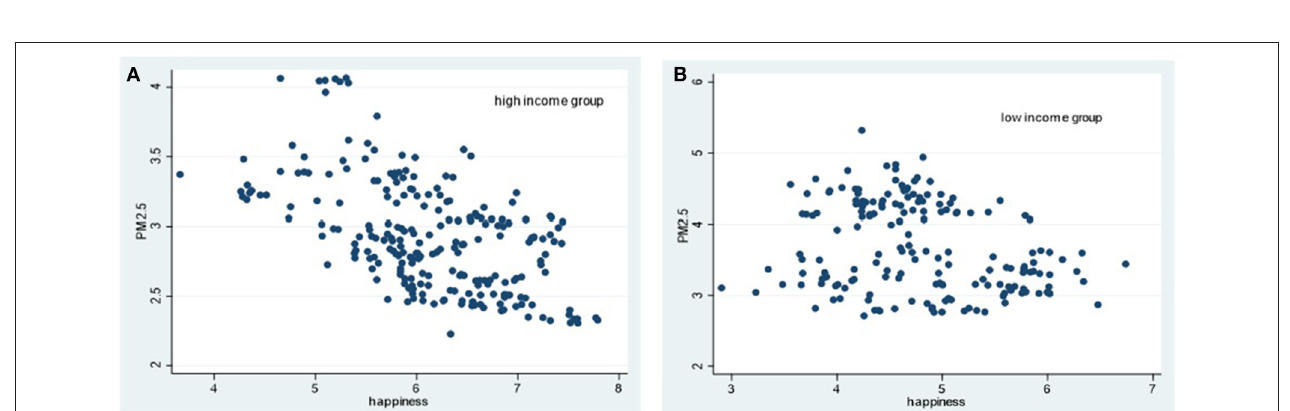
FIGURE 1 | Scatter diagram of relationship between PM2.5 concentration and happiness in different income groups. (A) High income group. (B) Low income group.